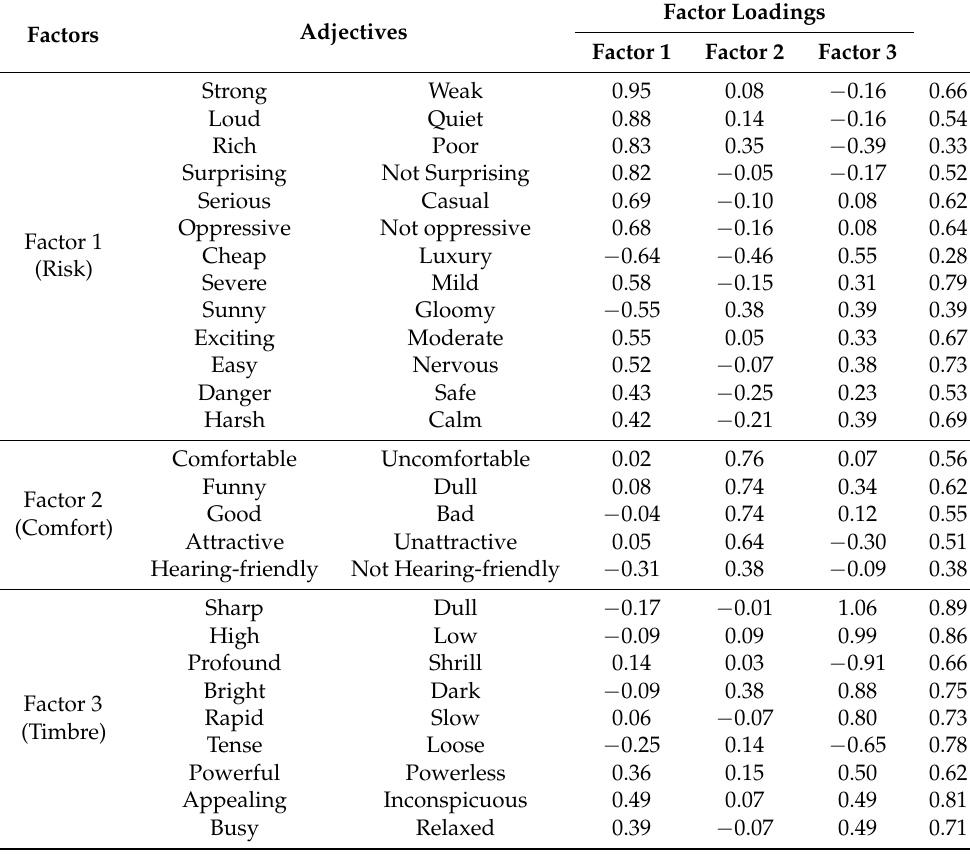
Table 4. Experimental results of factor analysis in case of Phase 1.